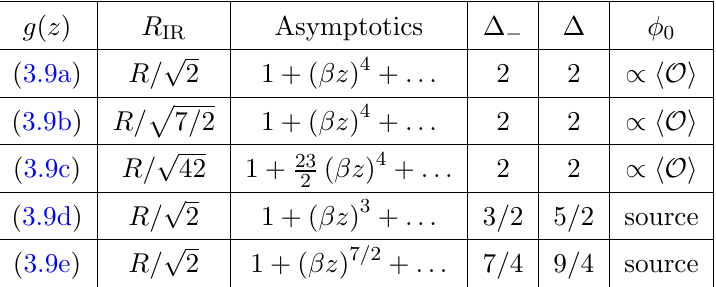
Table 2. Summary of properties of our choices of g ( z ) in eq.